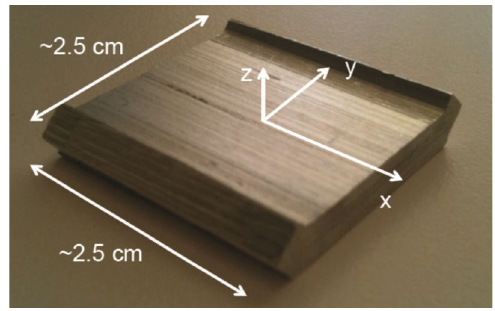
FIG. 8. Photograph of one of the aluminum vacuum chamber samples (Sample #2). The beam direction is along x . Note the distinct “ ridges ” which run parallel to the x -direction.